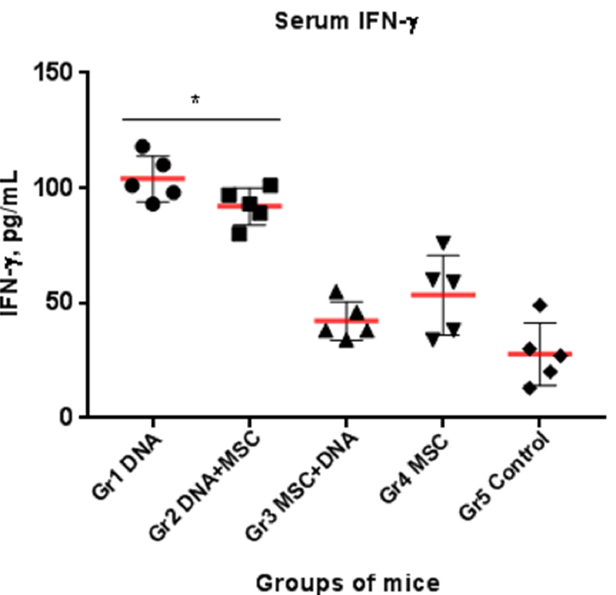
Figure 5. Comparative level of IFN- γ in the blood sera of immunized mice. Each group (5 mice) received the DNA plasmid and/or naïve MSCs during two injections with a three-week interval. After completion of immunizations, the level of IFN- γ in the sera was evaluated by ELISA; * p < 0.05 compared to the control (Group 5).